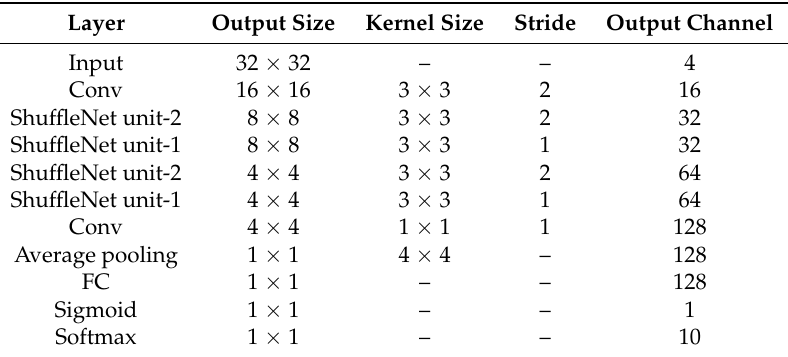
Table 2. Detailed architecture of the discriminator D in